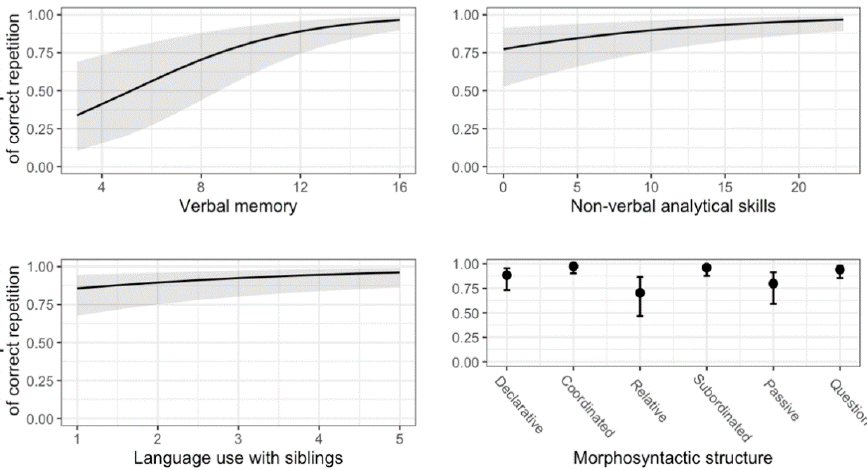
Figure 7. Predicted probabilities of a correct response given each fixed effect in the optimal model of English T2, predicting correct repetition of target morphosyntactic structure.